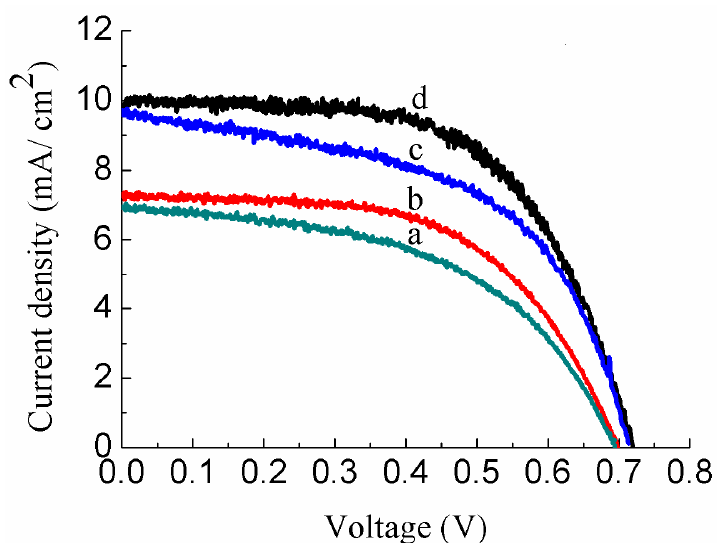
Figure 9. Photocurrent–voltage (J-V) characteristics of Au (0.0, 0.5, 1.0 and 1.5 wt%)-doped ZnO–Sm nanoparticle films. Table 3. I-V and electrochemical impedance spectroscopy (EIS) measurements of Au (0.0, 0.5, 1.0